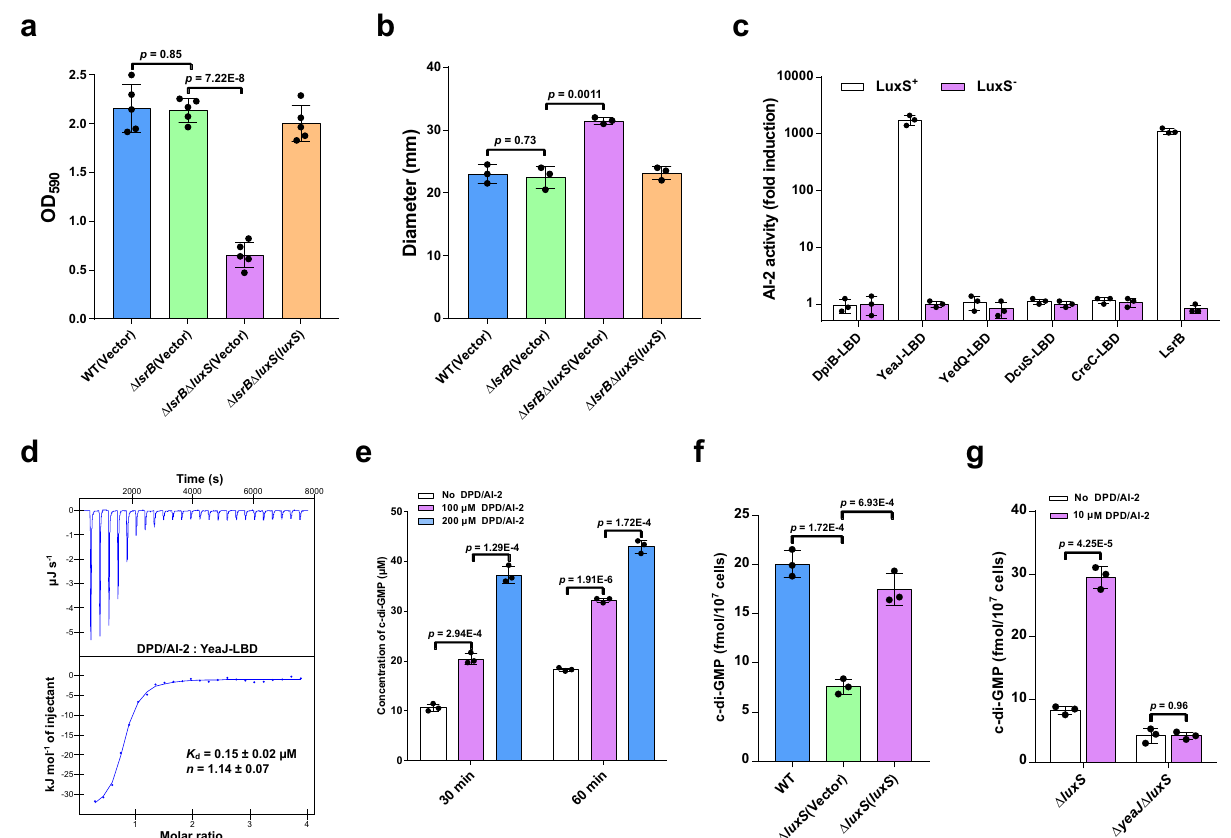
Fig.1|AI-2increasesintracellularc-di-GMPlevelsbydirectlyengagingtheDGC YeaJ in S . Typhimurium. a AI-2 regulates bio fi lm formation in S . Typhimurium independent of LsrB. Bio fi lms were stained with crystal violet and quanti fi ed using optical density measurement. Data were mean±s.e.m. of fi ve independent experiments. b AI-2 regulates the swimming motility of S . Typhimurium indepen- dent of LsrB. Data were mean±s.e.m. of three independent experiments. c YeaJ- LBD is capable of retaining AI-2. Bioluminescencein V.harveyi MM32( luxN − , luxS −